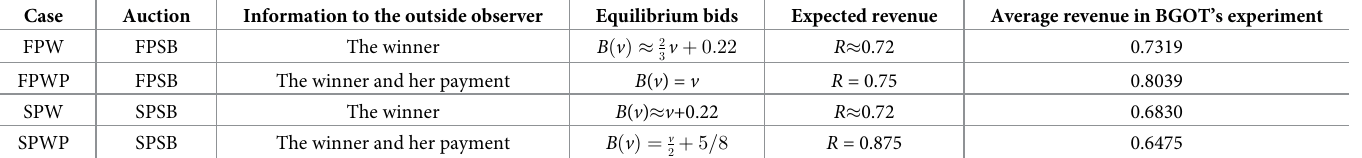
Table 1. Equilibrium bids and revenue for risk-neutral bidders for γ = 1/2, n = 3, F = U